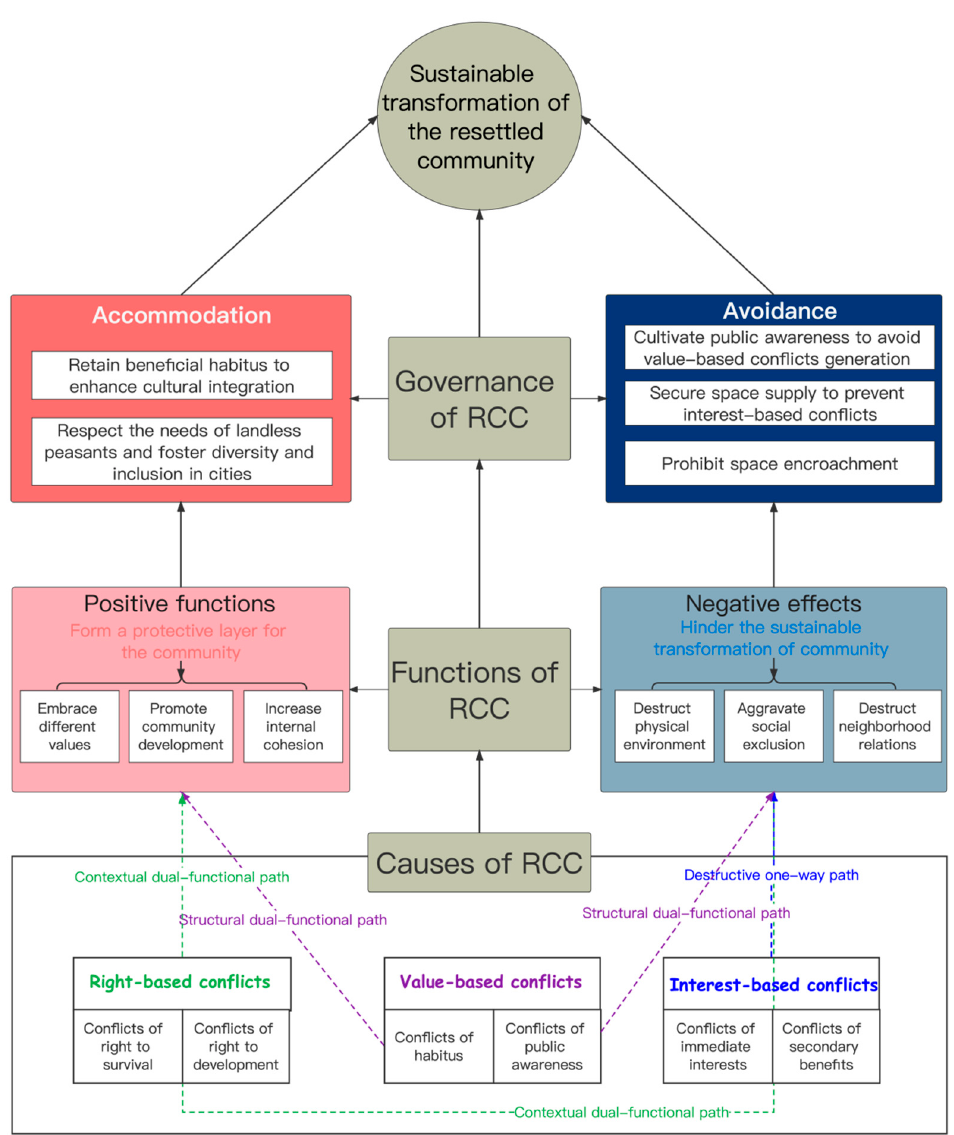
Figure 9. A framework for dual governance logic of RCC. Source: Authors.